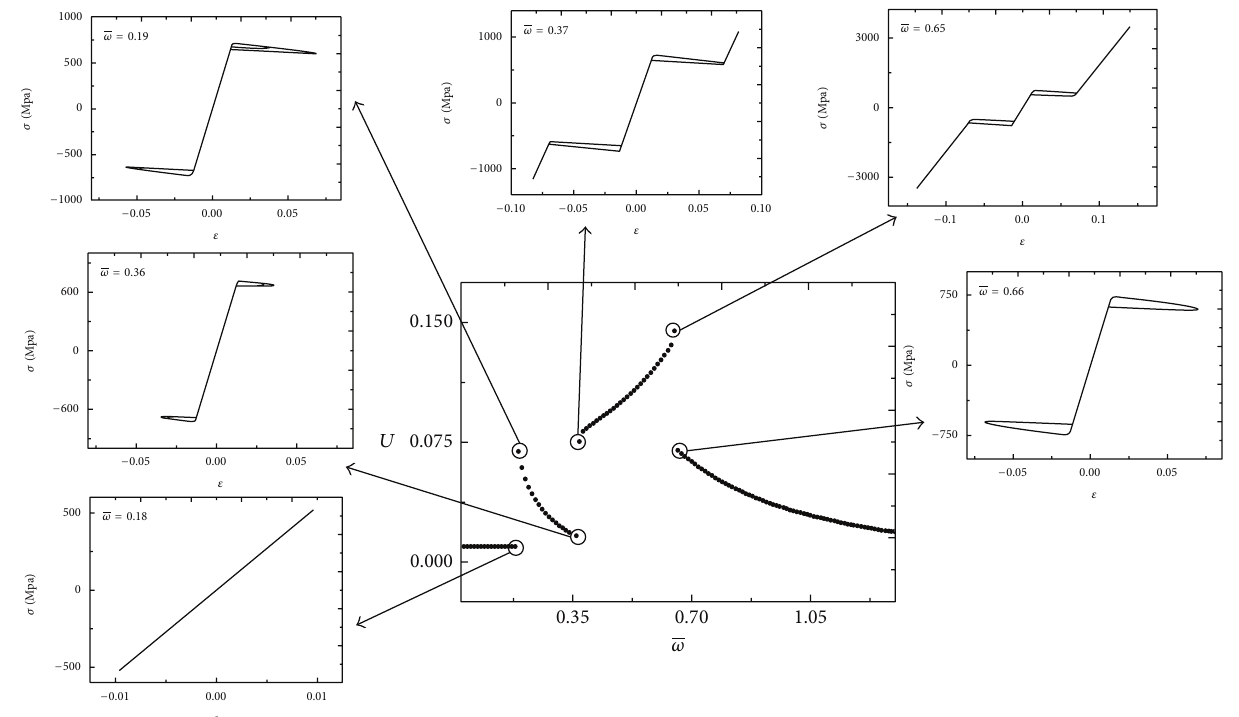
Figure 10: Up-sweep jumps with 𝛿 = 0.012 : comparison between frequency response and stress-strain curves. increasing and decreasing the forcing frequency. This